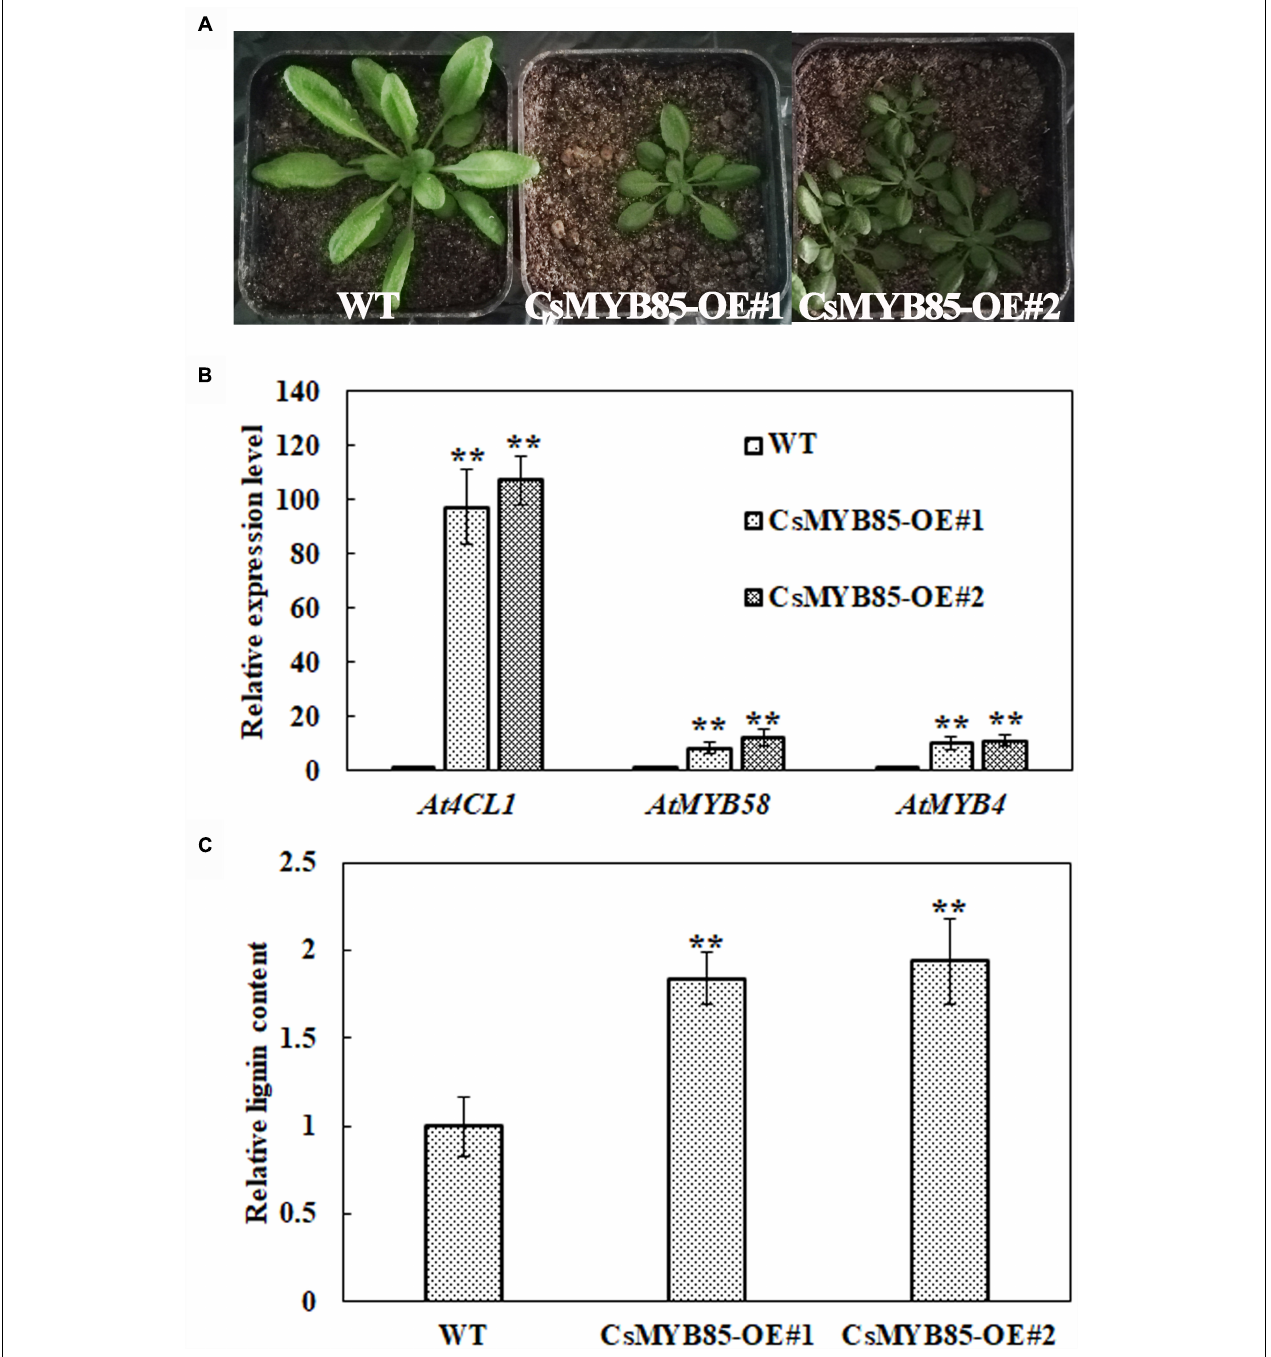
FIGURE 8 | CsMYB85 overexpression increased lignin content in Arabidopsis thaliana. (A) Six-week-old seedlings of wild-type A. thaliana (WT, left), MYB85-OE#1 (CsMYB85 overexpression line 1, center), and MYB85-OE#2 (CsMYB85 overexpression line 2, right). Note the smaller leaves of MYB85-OE#1 and MYB85-OE#2 plants relative to those of the WT. (B) Expression levels of At4CL1 ( AT1G51680 ), AtMYB58, and AtMYB4 were increased in CsMYB85-OE#1 and MYB85-OE#2 plants compared with those in WT plants. At4CL1 , AtMYB58, and AtMYB4 expression levels in the WT were set to 1. AtActin was used as an internal reference gene. Error bars represent the standard errors of four biological replicates. Student’s t -test: ∗∗ P < 0.01. (C) Lignin content in WT, CsMYB85-OE#1, and MYB85-OE#2 plants. Data are the averages of four biological replicates in WT, CsMYB85-OE#1, and MYB85-OE#2 plants. Error bars represent standard errors. Student’s t -test: ∗∗ P <